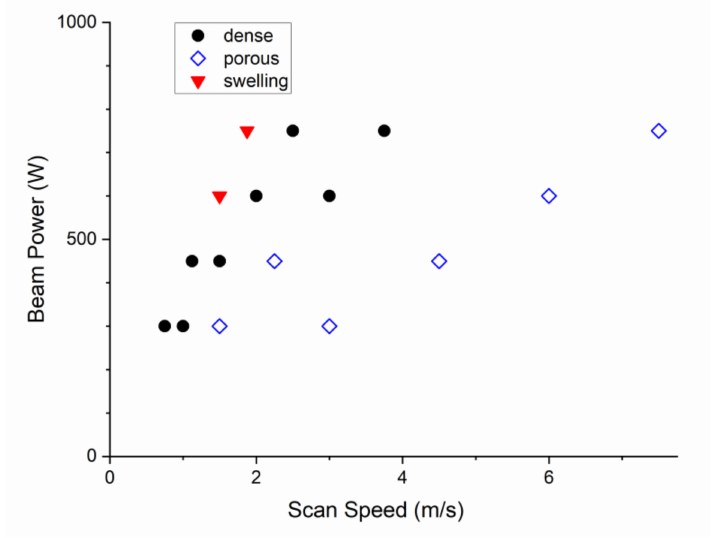
Figure 4. PBF-EB process window for X37CrMoV5-1 for 70 µ m layer thickness and 100 µ m hatch distance. Full circles mark dense specimen, while open diamonds stand for porous material and full triangles for strong swelling.